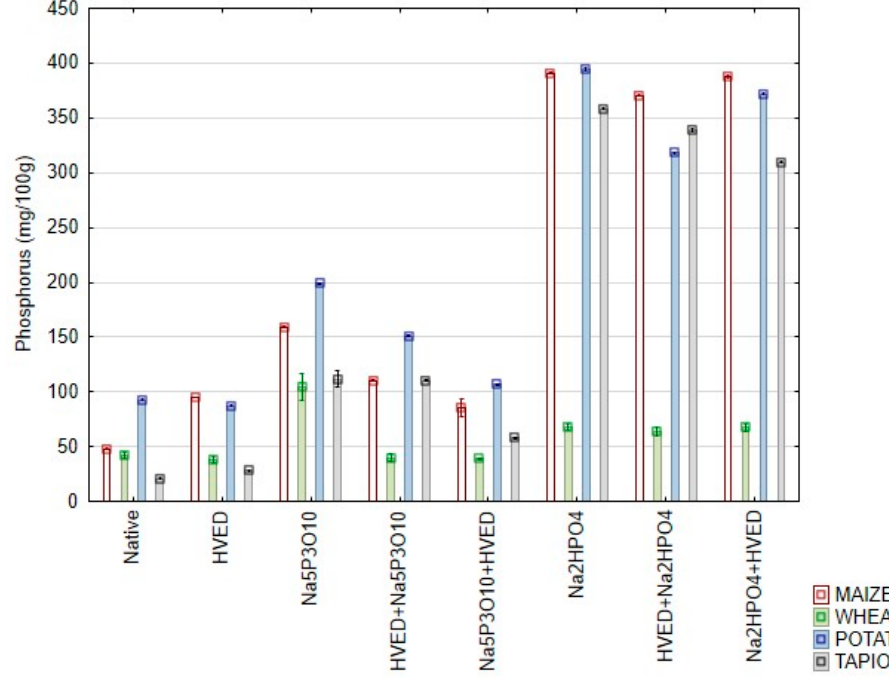
Figure 1. Phosphorus contents (mean ± 2SD) in starches modified with high-voltage electrical discharge (HVED) and phosphorylation.